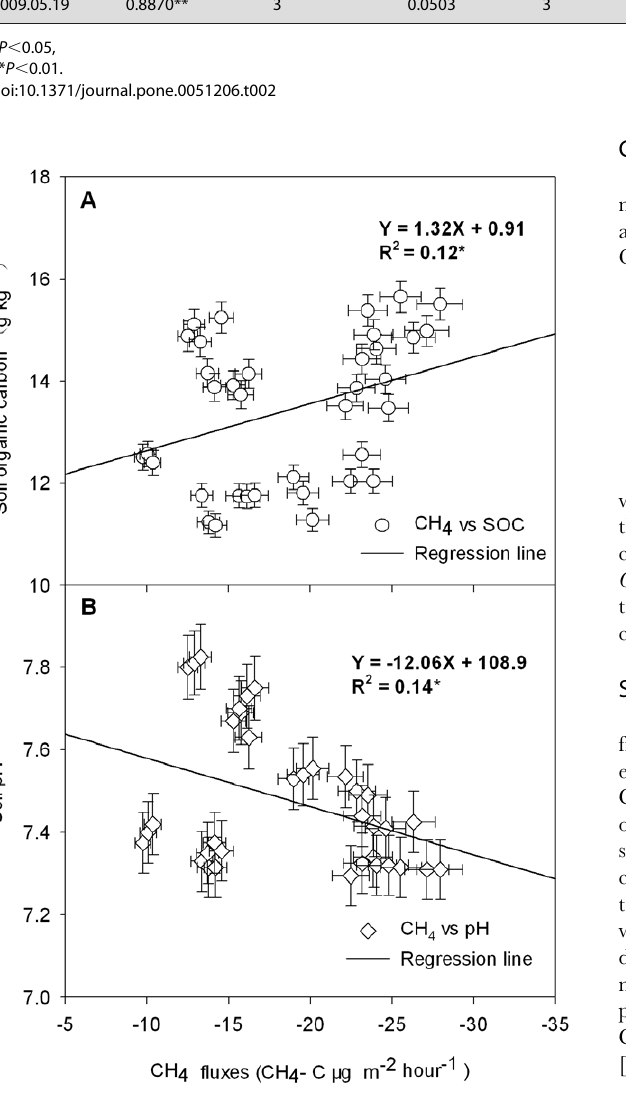
Sampling time Soil temperature